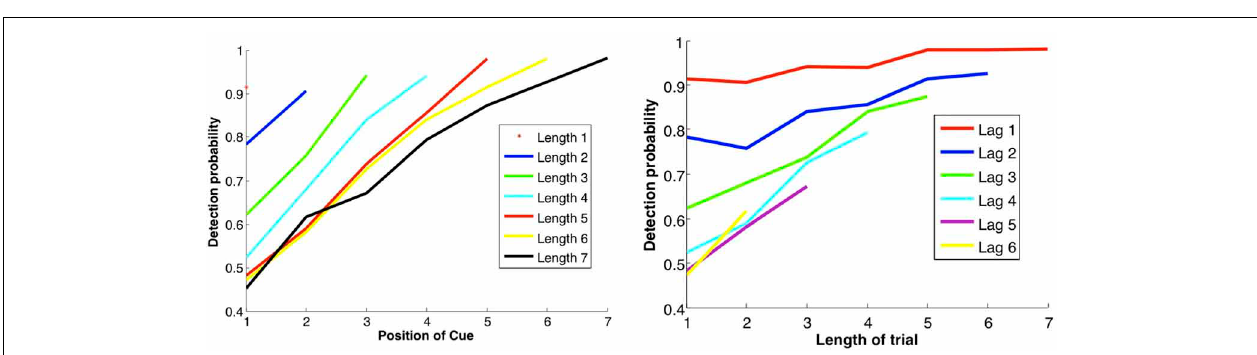
p fire , high = 0 . 9, Right panel: fraction of selective units active on intermediate test images. First boxplot show the initial activity upon presentation. The second boxplot shows the activity after running the network in the high noise regime starting with the high activity level of the sample image. In contrast to the DMS case, the increased inhibition causes most test images to die out.